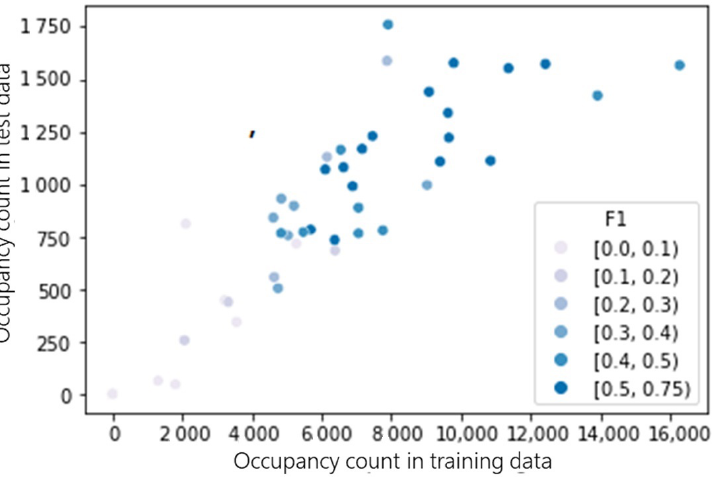
Figure 5. Occupancy count in training and test data and corresponding F1 score.